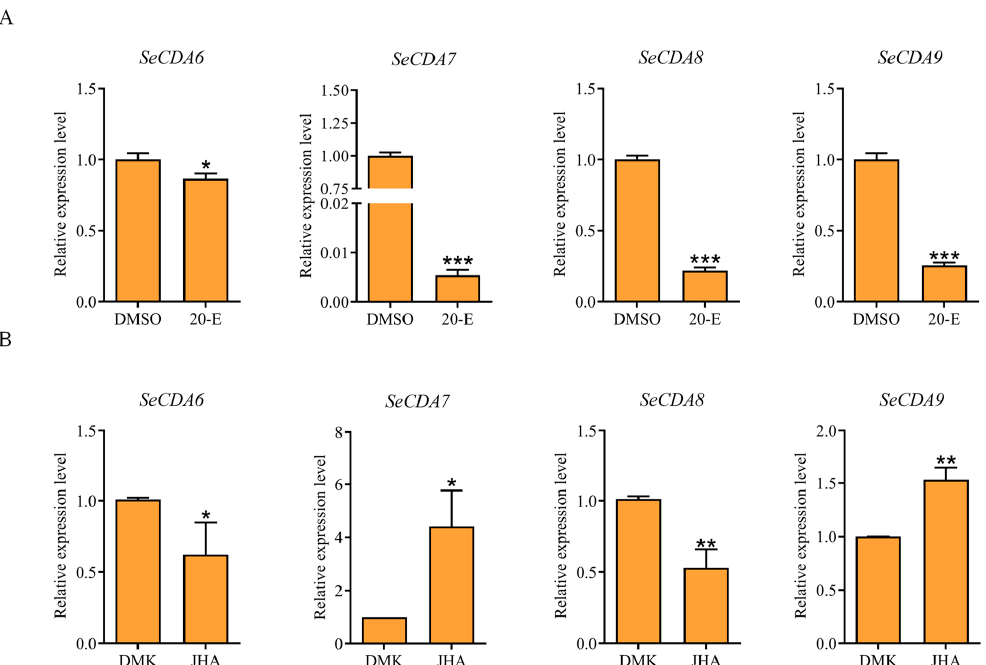
Figure 5. Effect of two hormone analogs on the expression of SeCDAs . ( A ) Effect of 20E on the expression of SeCDAs . DMSO was used in the control group. ( B ) Effect of JHA on the expression of SeCDAs . DMK was used in the control group. Data are reported as means ± SE of three independent biological replications (*** p < 0.001; ** p < 0.01; * p < 0.05).